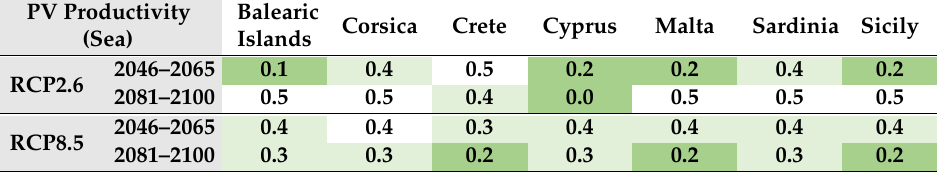
Table A5. This is equivalent to Table A4, but this is computed over the sea. Domains used to do the calculations are presented in Table 1.